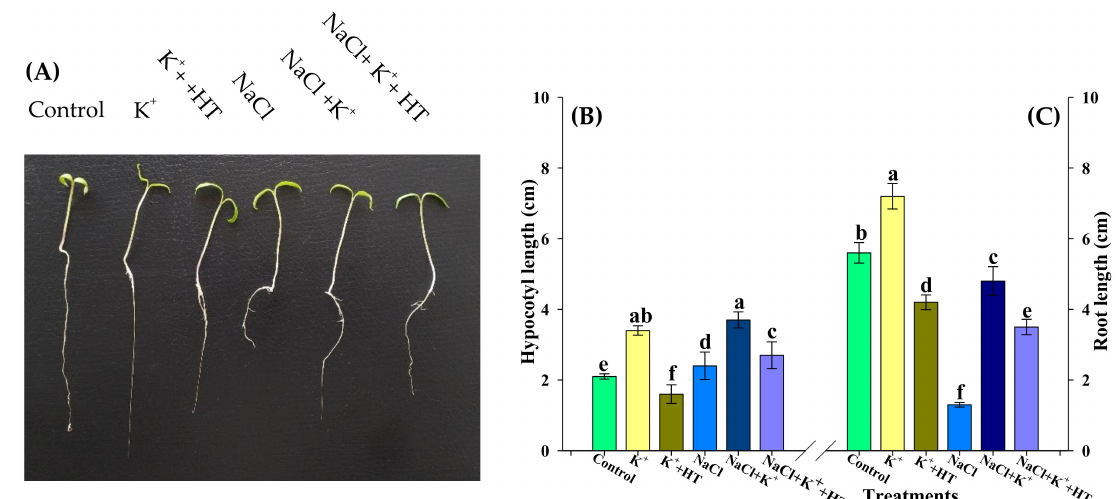
Figure 1. Effect of various treatments on ( A ) Phenotypic appearance, ( B ) hypocotyl length, and ( C ) root length of tomato. Double deionized water (control), 5 mM K 2 CO 3 (K + ), 100 mM NaCl (NaCl), 1 mM hypotaurine (HT: H 2 S scavenger). Values are means of five independent replicates, with bars indicating SE. Bars with different letters indicate that differences were statistically significant at p < 0.05